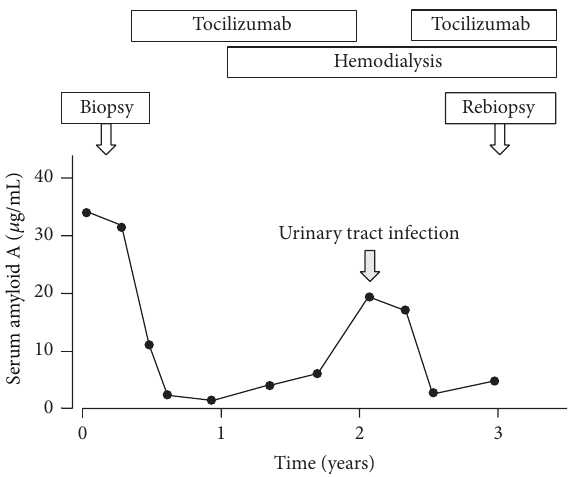
Figure 4: The clinical course and the changes of patient’s serum amyloid A (SAA) levels. The tocilizumab treatment controlled her SAA levels, although there were transient SAA level elevations due to a urinary tract